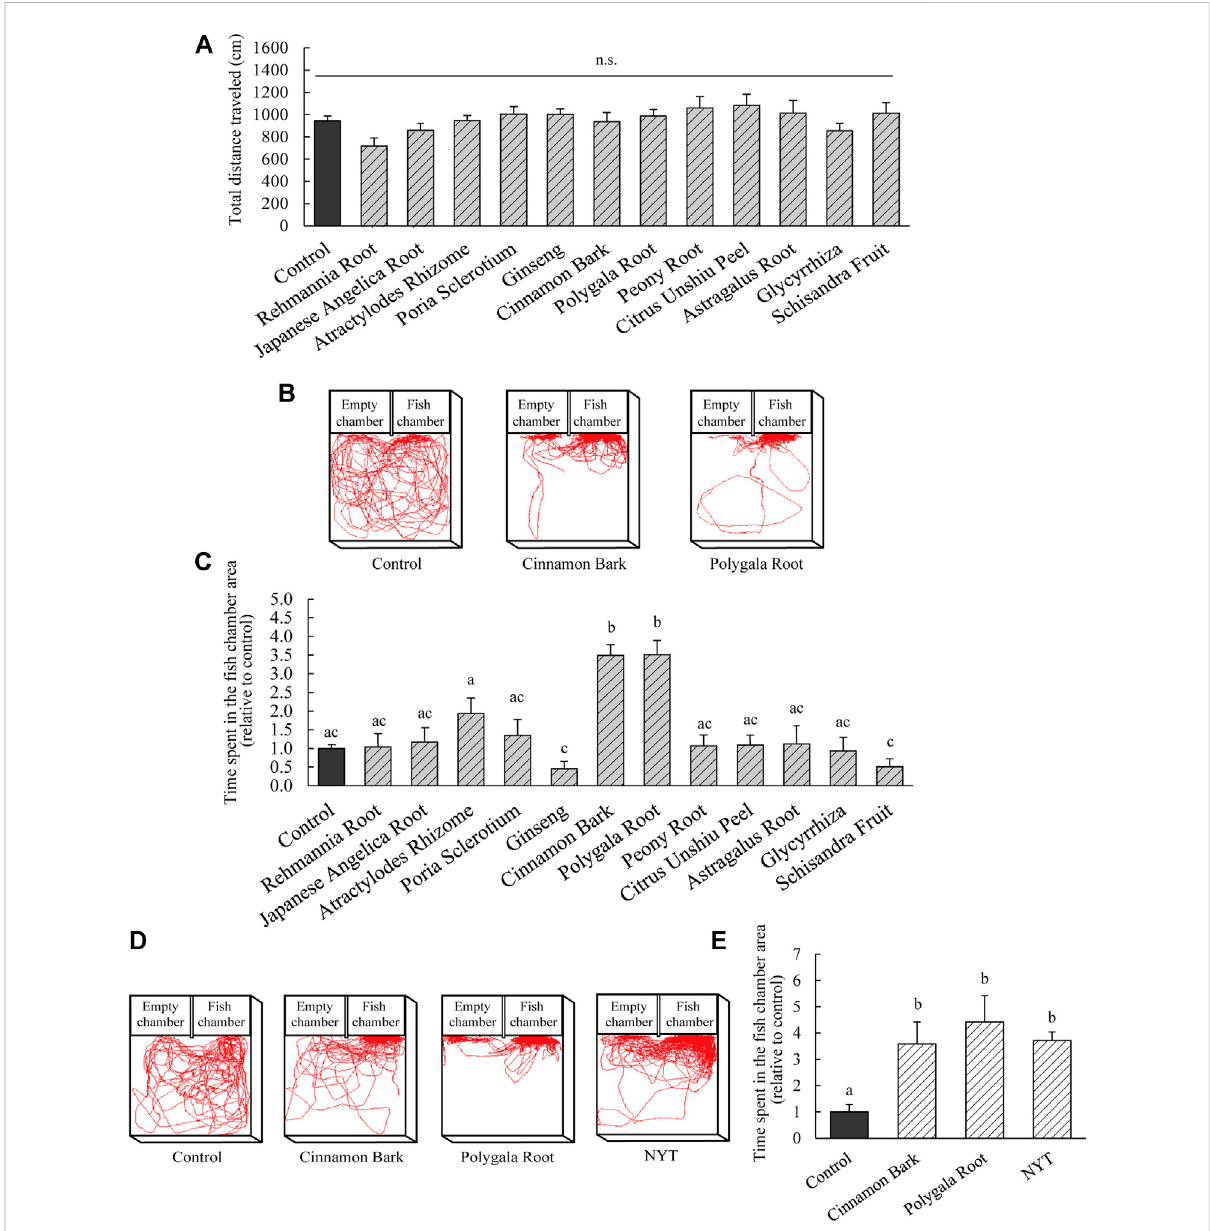
GABA neurons. We identi fi ed Cinnamon Bark and